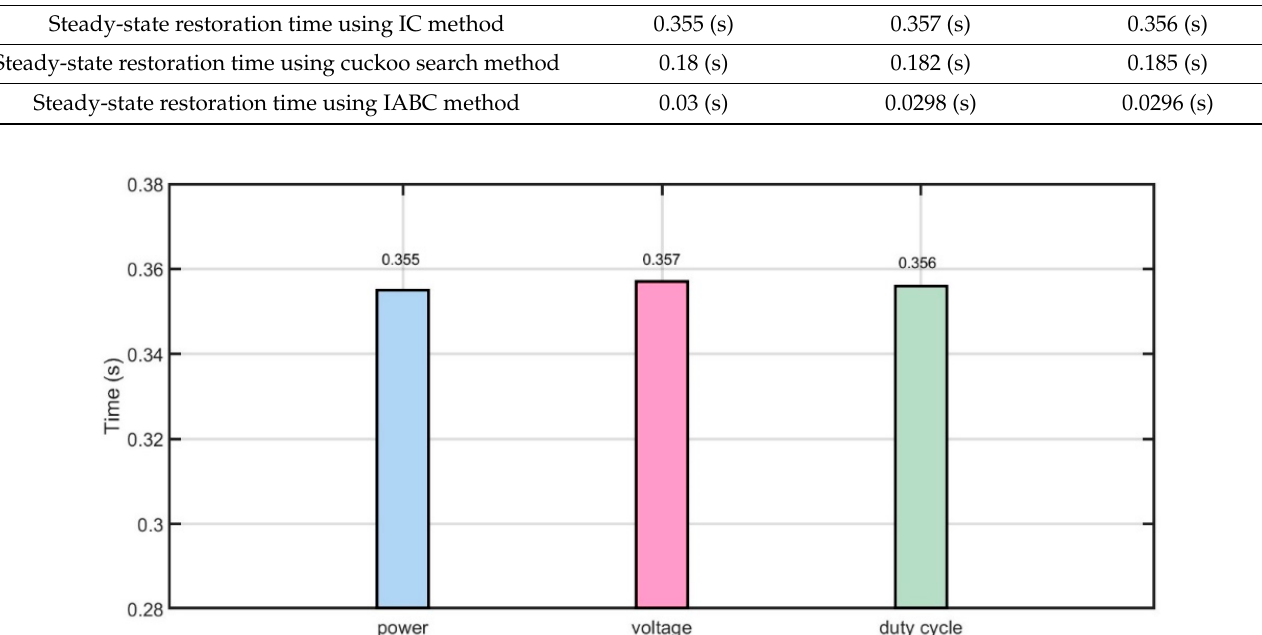
Figure 19. The steady-state restoration time using the incremental conductance method.